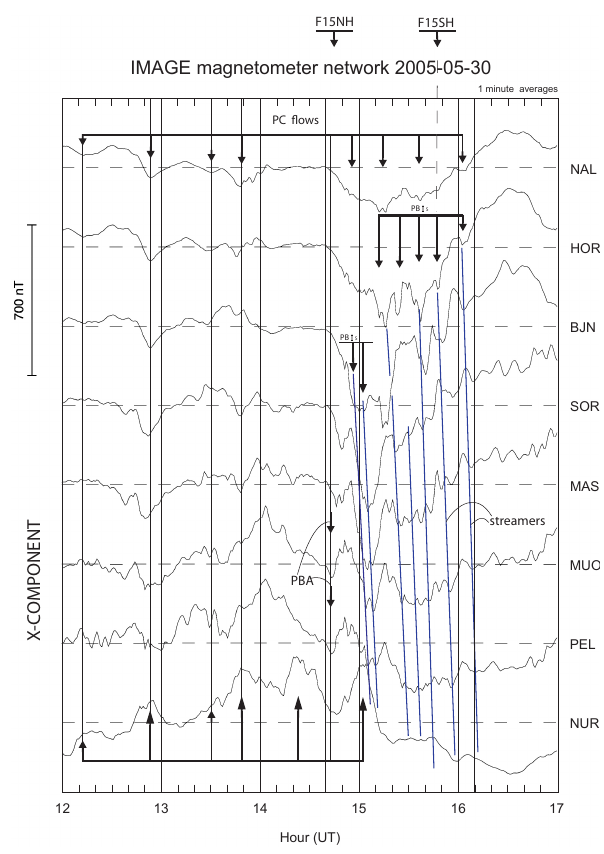
Fig. 5. X-component magnetic deflections from ground stations in Svalbard – Scandinavia – Finland, ordered by decreasing latitude, during the interval 12:00–17:00UT on 30 May 2005. Various fea- tures are marked in the figure: (i) polar cap flow enhancements (up- per panel), (ii) poleward boundary intensifications (PBIs) (second and third panels), (iii) auroral streamers (blue tilted lines), (iv) PBA at 14:43UT and EEJ enhancements (bottom panel). Passes of satel- lites F15 across the pre-midnight auroral oval in the Northern (NH) and Southern (SH) Hemispheres are marked at the